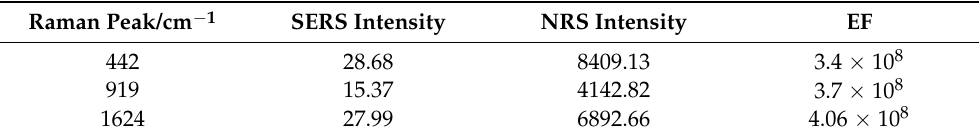
Figure S6 in Supporting Information). Two main Raman peaks at 442 cm − 1 and 1624 cm −